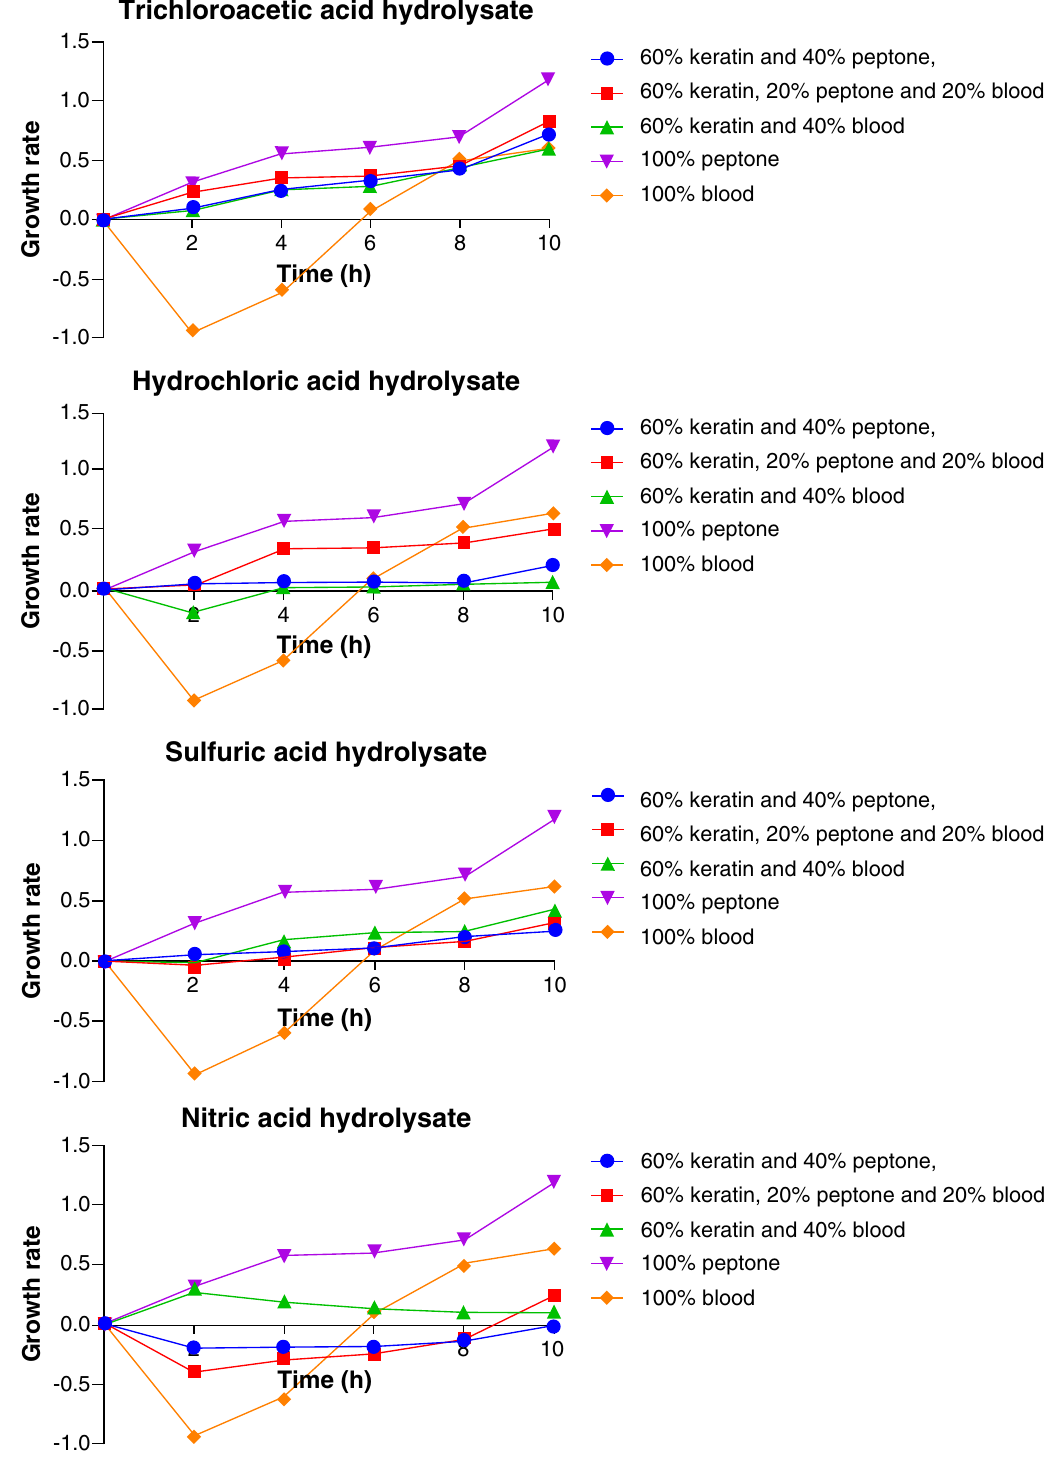
Figure 1. Growth rate of Candida carpohila in media with the TCA, HCl, H